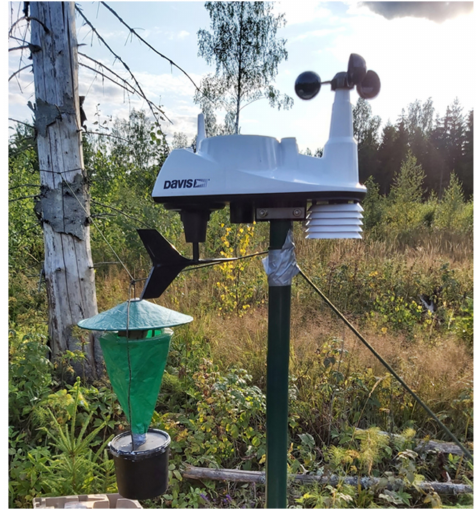
Figure 1. Data collection: a bait trap in an Estonian forest clearcut with a portable weather station next to it. The height of the metal pole is 1.5